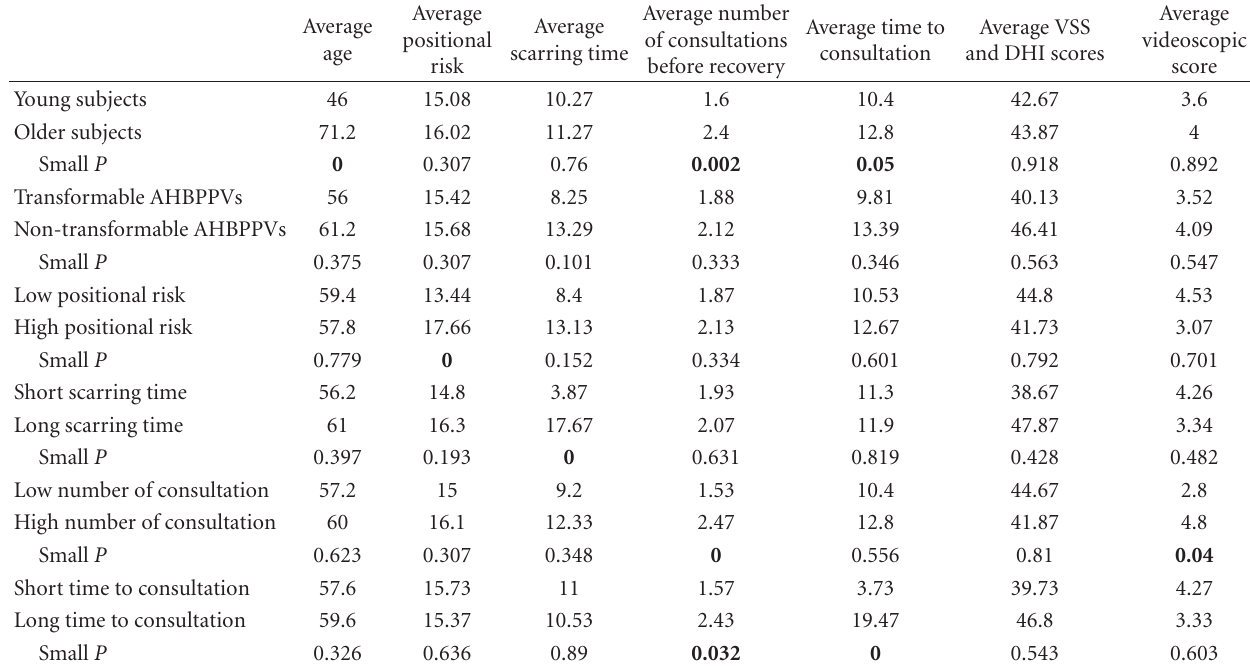
Table 2: Summarizes our statistical study and the Fischer